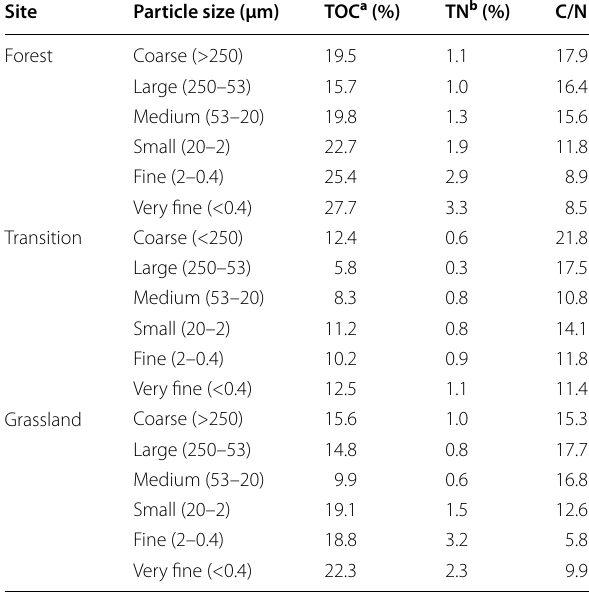
Table 3 Content of total organic C, N and C/N ratio in each particle-size fraction in different sampling locations